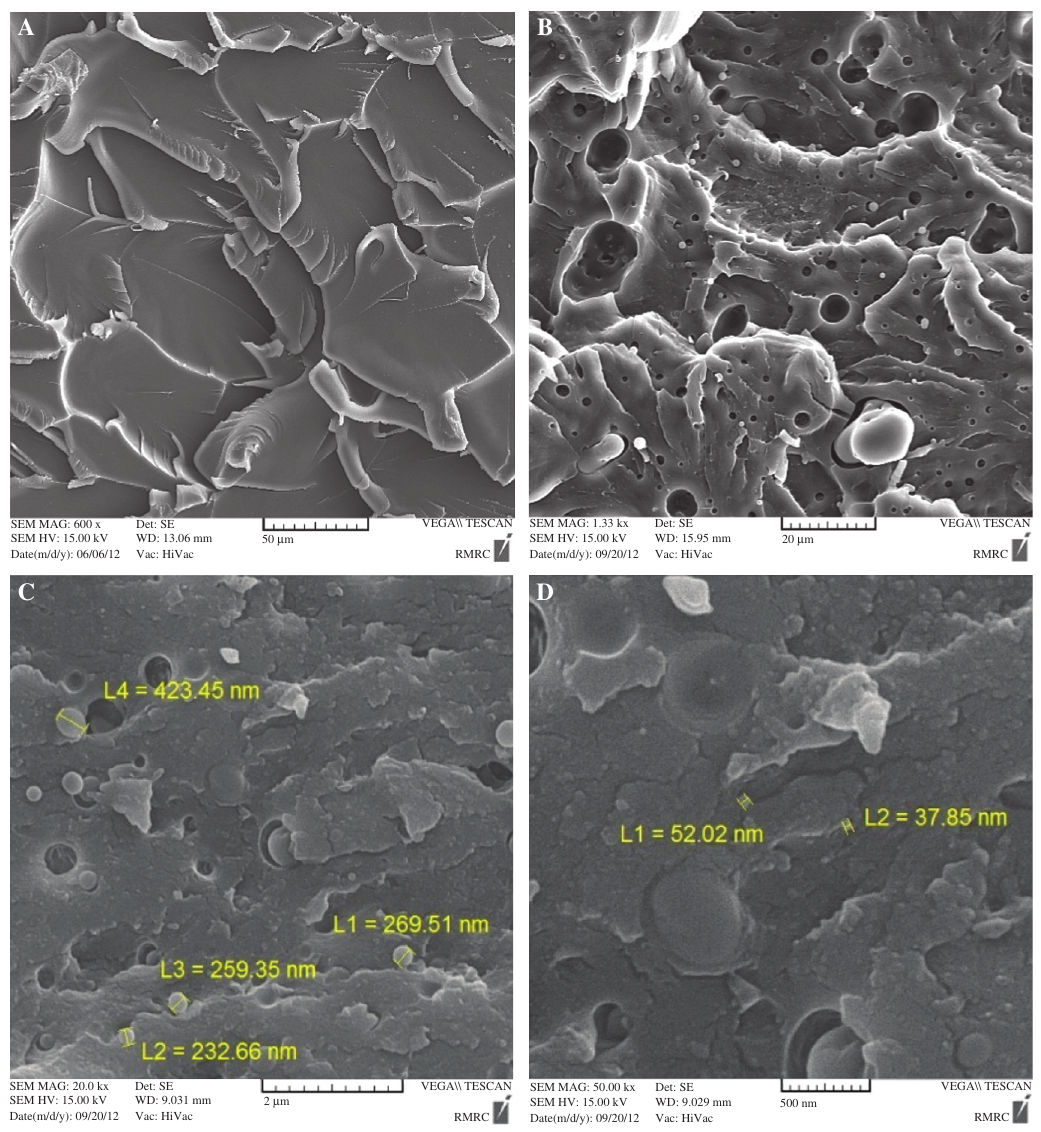
Figure 10 Scanning electron micrographs of the fracture surface of (A) neat epoxy samples having (B) MWCNT (1.3 wt%), (C) HIPS (3.6 wt%) and (D) MWCNT (1.3 wt%)+HIPS (3.6